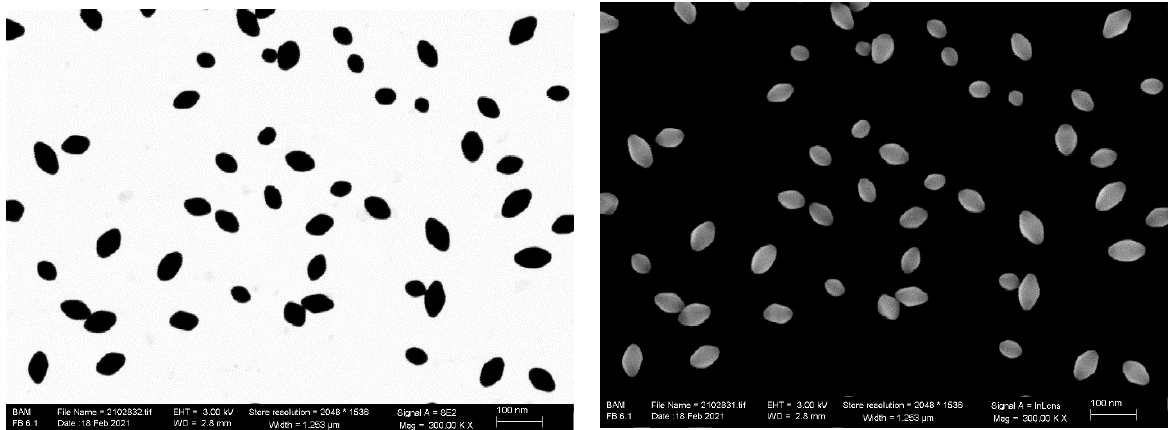
Figure 11. Three kilovolt STEM-in-SEM micrograph of the TiO 2 NPs deposited on a carbon film TEM grid ( left ) and the corresponding 3 kV SEM (Zeiss-Supra40) secondary electrons InLens micrograph ( right ).